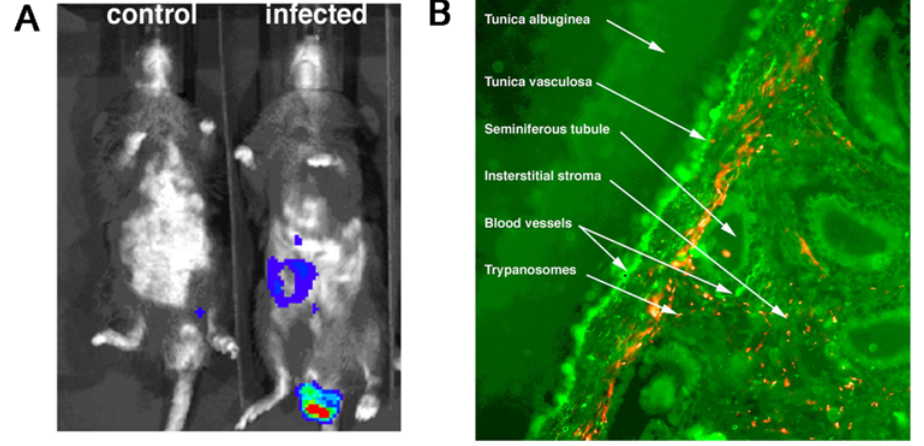
Figure 3. Testis localization of bioluminescent T.b.brucei . A. RAG1 2 / 2 mice at 0 (left) and 7 days after infection (right) with 2 6 10 4 T. brucei Lister 427 were inoculated with coelenterazine and biophotonic emission was assessed. B. Immunostaining of trypanosomes and endothelial cells in sections of testis from mice 25 days after infection with 2 6 10 4 T.b. brucei Antat 1.1E i.p. Numerous parasites (in red) are observed in the blood vessels and in the interstitial tissue between the seminiferous tubules. Magnification: 250 6 .